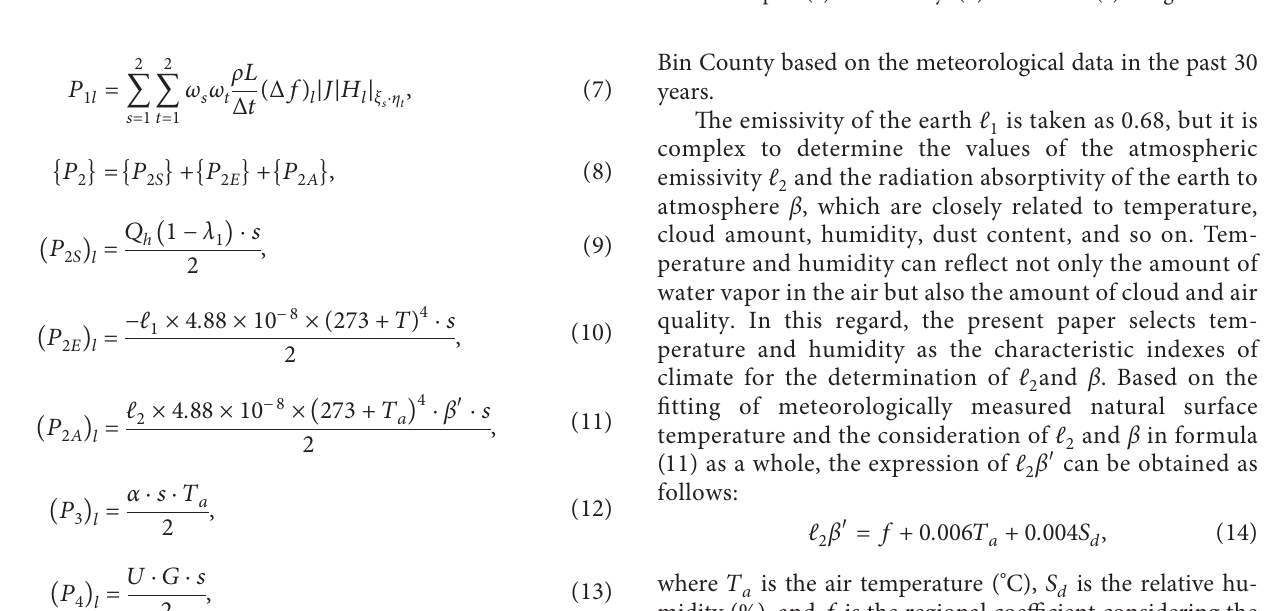
Figure 5: Moisture content variation of shallow loess at different sites with depth. (a) Bin County. (b) Luochuan. (c)